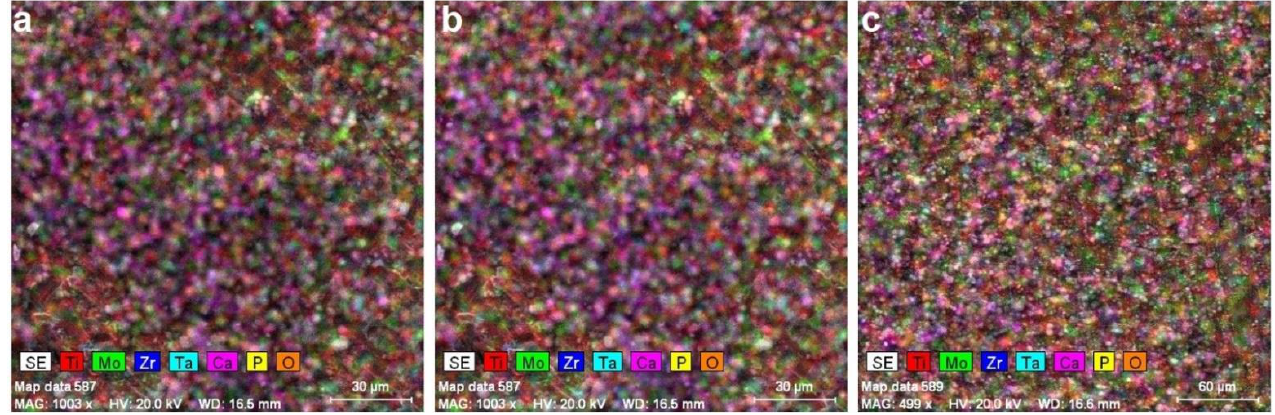
Table 4. The thickness of the deposited layers.